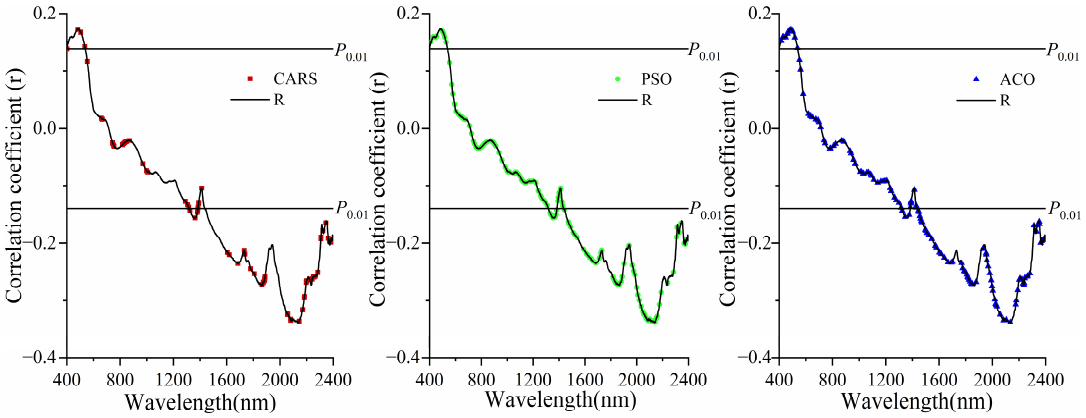
Figure 4. Correlation between soil reflectance and SOC.